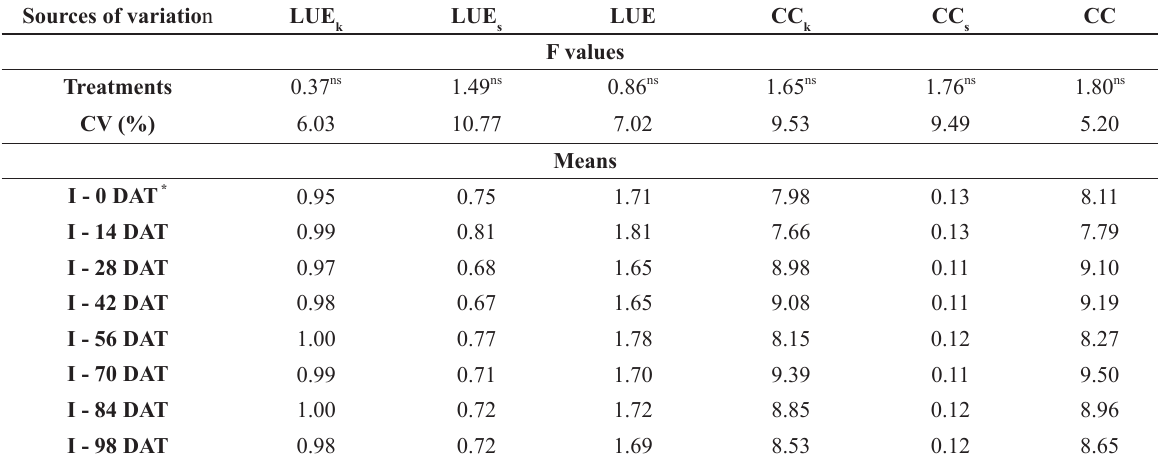
Summary of variance analysis (F values, coefficients of variation and averages) for the indices: efficiency in the use of kale (LUE ), New Zealand spinach (LUE ) and intercropping (LUE), competitiveness coefficient (CC), of kale (CC k s Zealand spinach (CC ) in function of the culture s